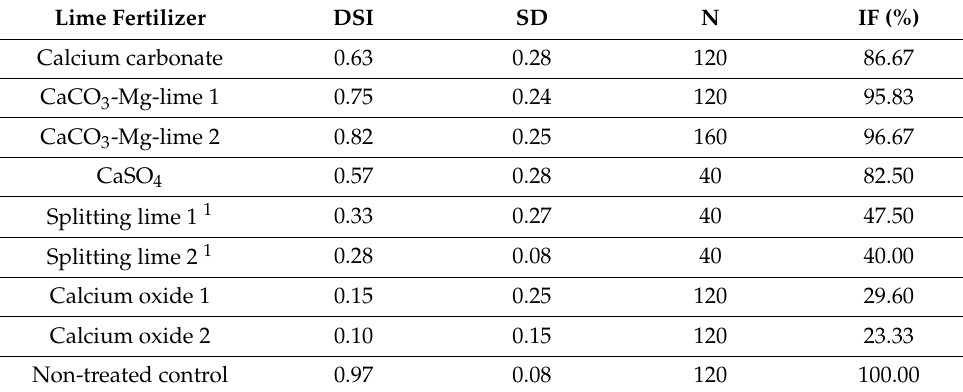
Figure 1. Effect of lime fertilizer on the disease severity index (DSI) of Plasmodiophora brassicae on the susceptible oilseed rape cv “Avatar”. Boxes and whiskers indicate interquartile ranges and subsequent 1.5-fold interquartile ranges. Different letters differ significantly at p < 0.05 according to Tukey’s honestly significant difference post hoc test on ranks of data. Table 2. Disease severity index (DSI). Standard deviation (SD), number of plants tested (N), infestation frequency